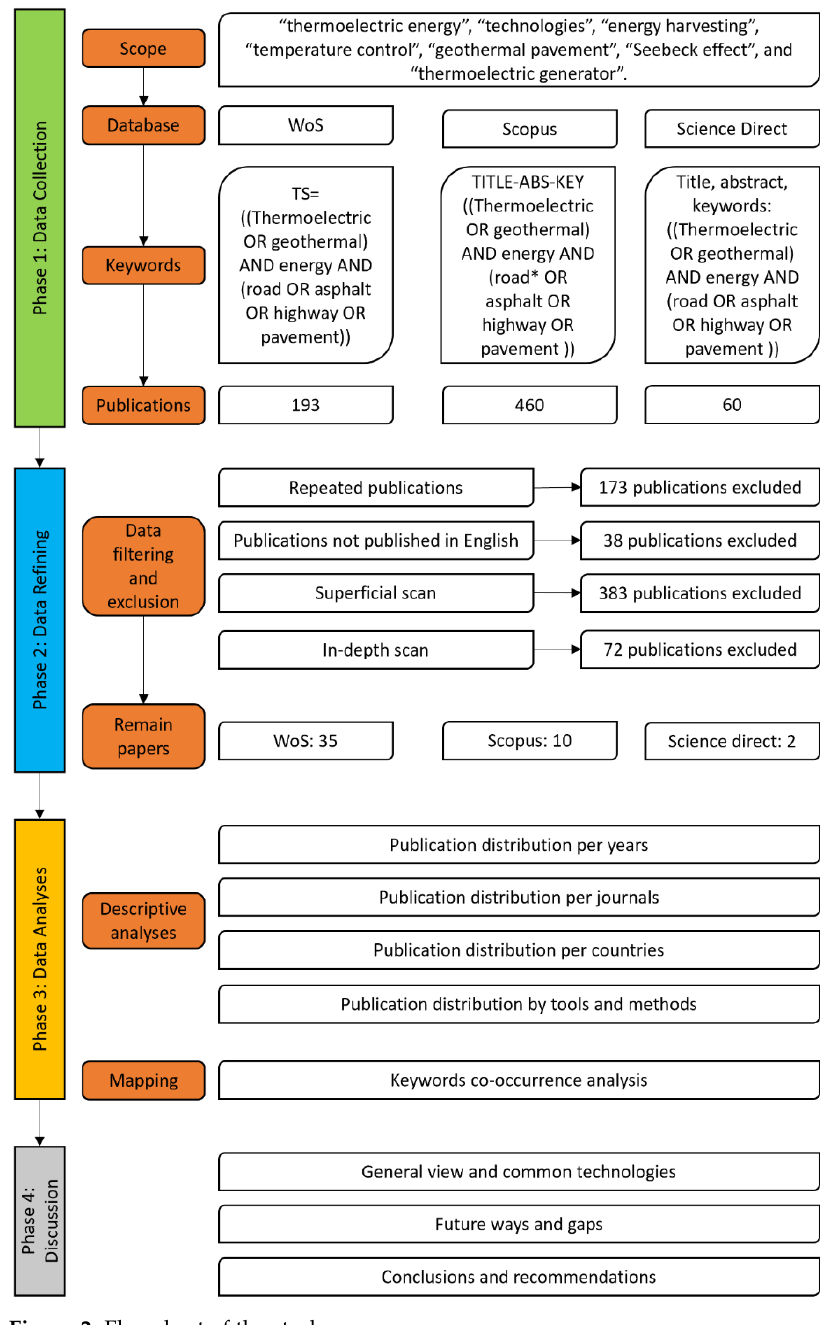
Figure 2. Flowchart of the study.